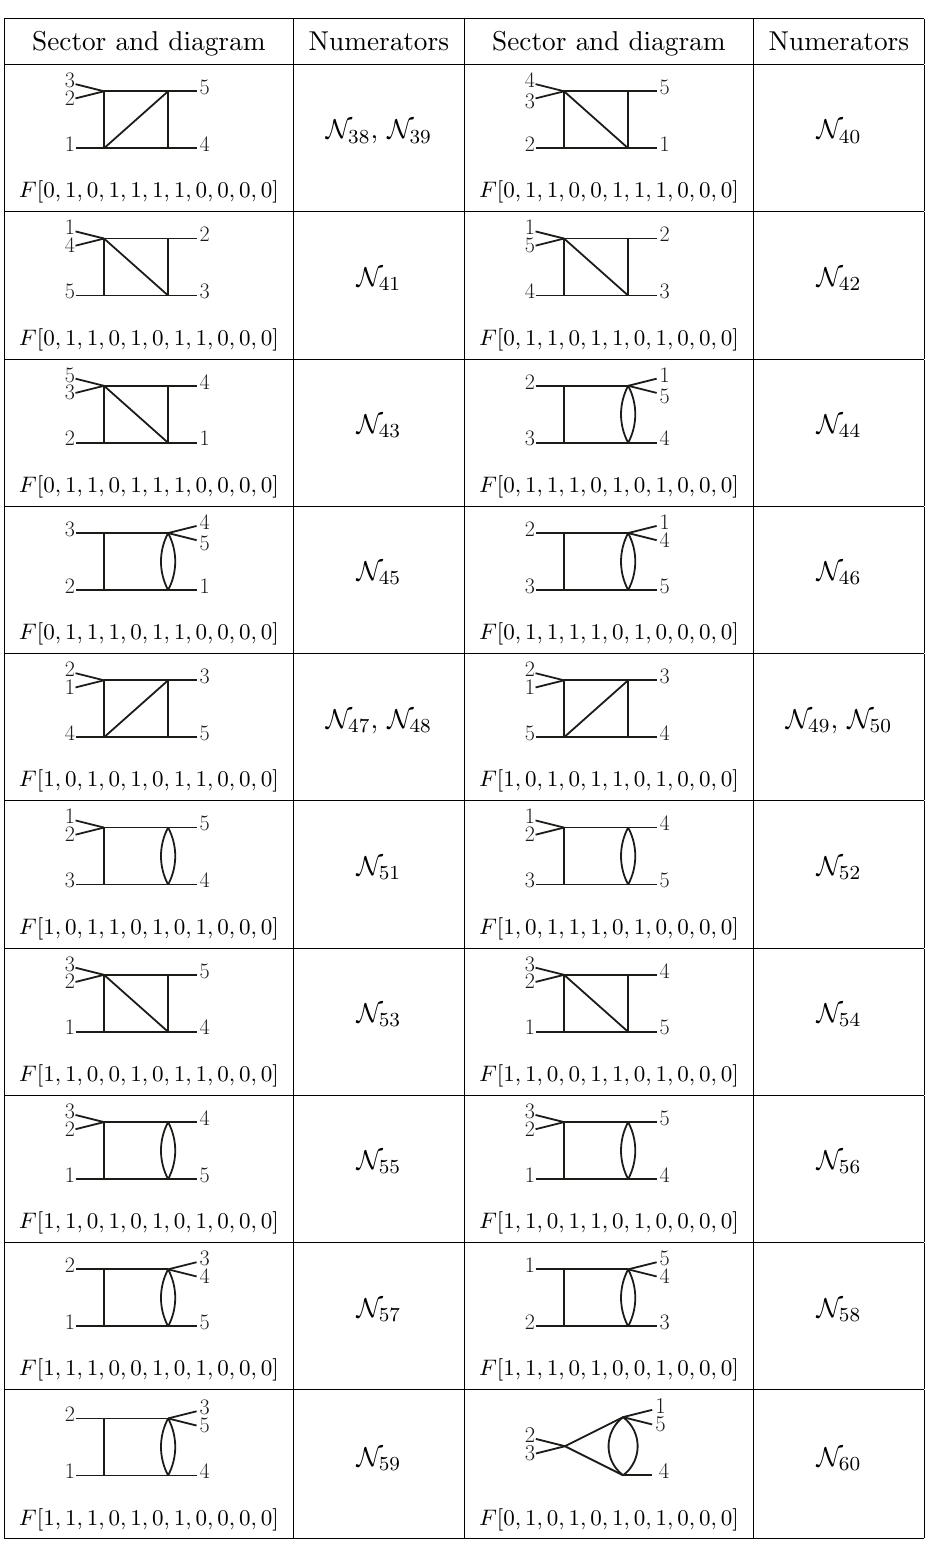
Table 2 . Diagrammatic representation of each sector and associated